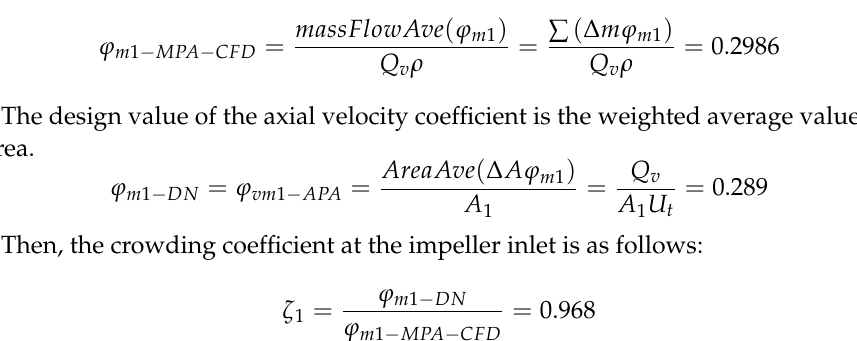
Axis Figure 17. The absolute velocity vector distribution near the impeller inlet hub wall.